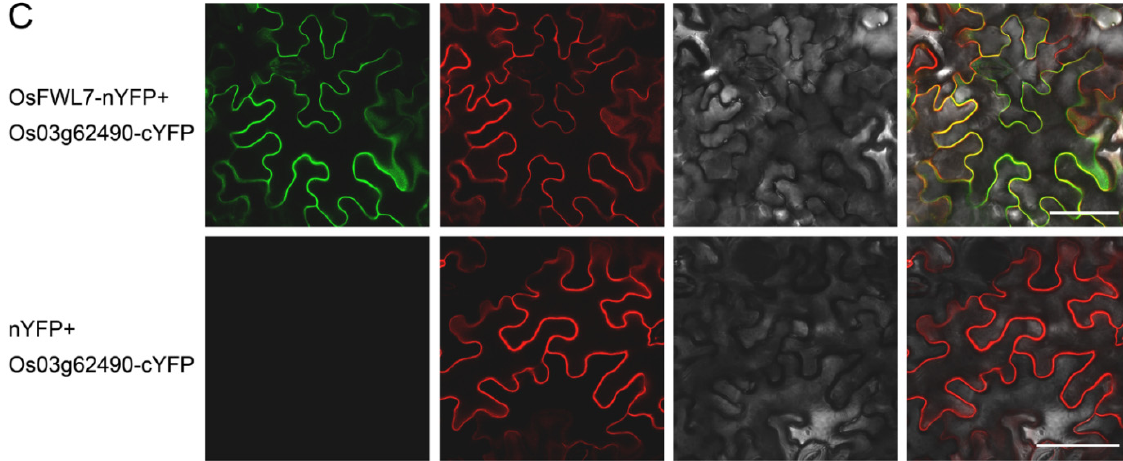
Figure 7. Detection of the interactions of rice FWL proteins with membrane microdomain marker proteins. ( A ) Yeast two- hybrid assays of the interactions between rice FWL proteins and membrane microdomain marker proteins. Transformed yeast cells were cultured on SD-Leu-Trp control medium and SD-Leu-Trp-Ade-His selective medium. AD, activation domain; BD, DNA binding domain. ( B , C ) Bimolecular fluorescence complementation (BiFC) assays verify the interaction of OsFWL7 with LOC_Os04g38900 ( B ) and LOC_Os03g62490 ( C ). The OsSCAMP1 protein was fused with mCherry and used as the plasma membrane marker. The YFP fluorescence, mCherry fluorescence, bright field, and merged images are shown. Bar = 50 µ